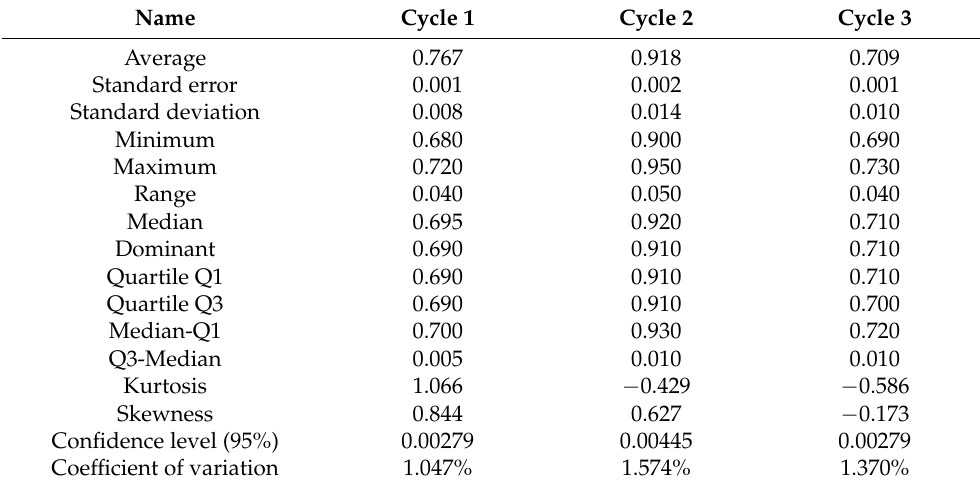
Figure 20. Box-and-whisker plot (scatter and shape of analysed data): tip-to face distance, cycle No. 1, 2 and 3. Table 2. Summary of the calculations used to present a box-and-whisker diagram for the tip-to face distance.